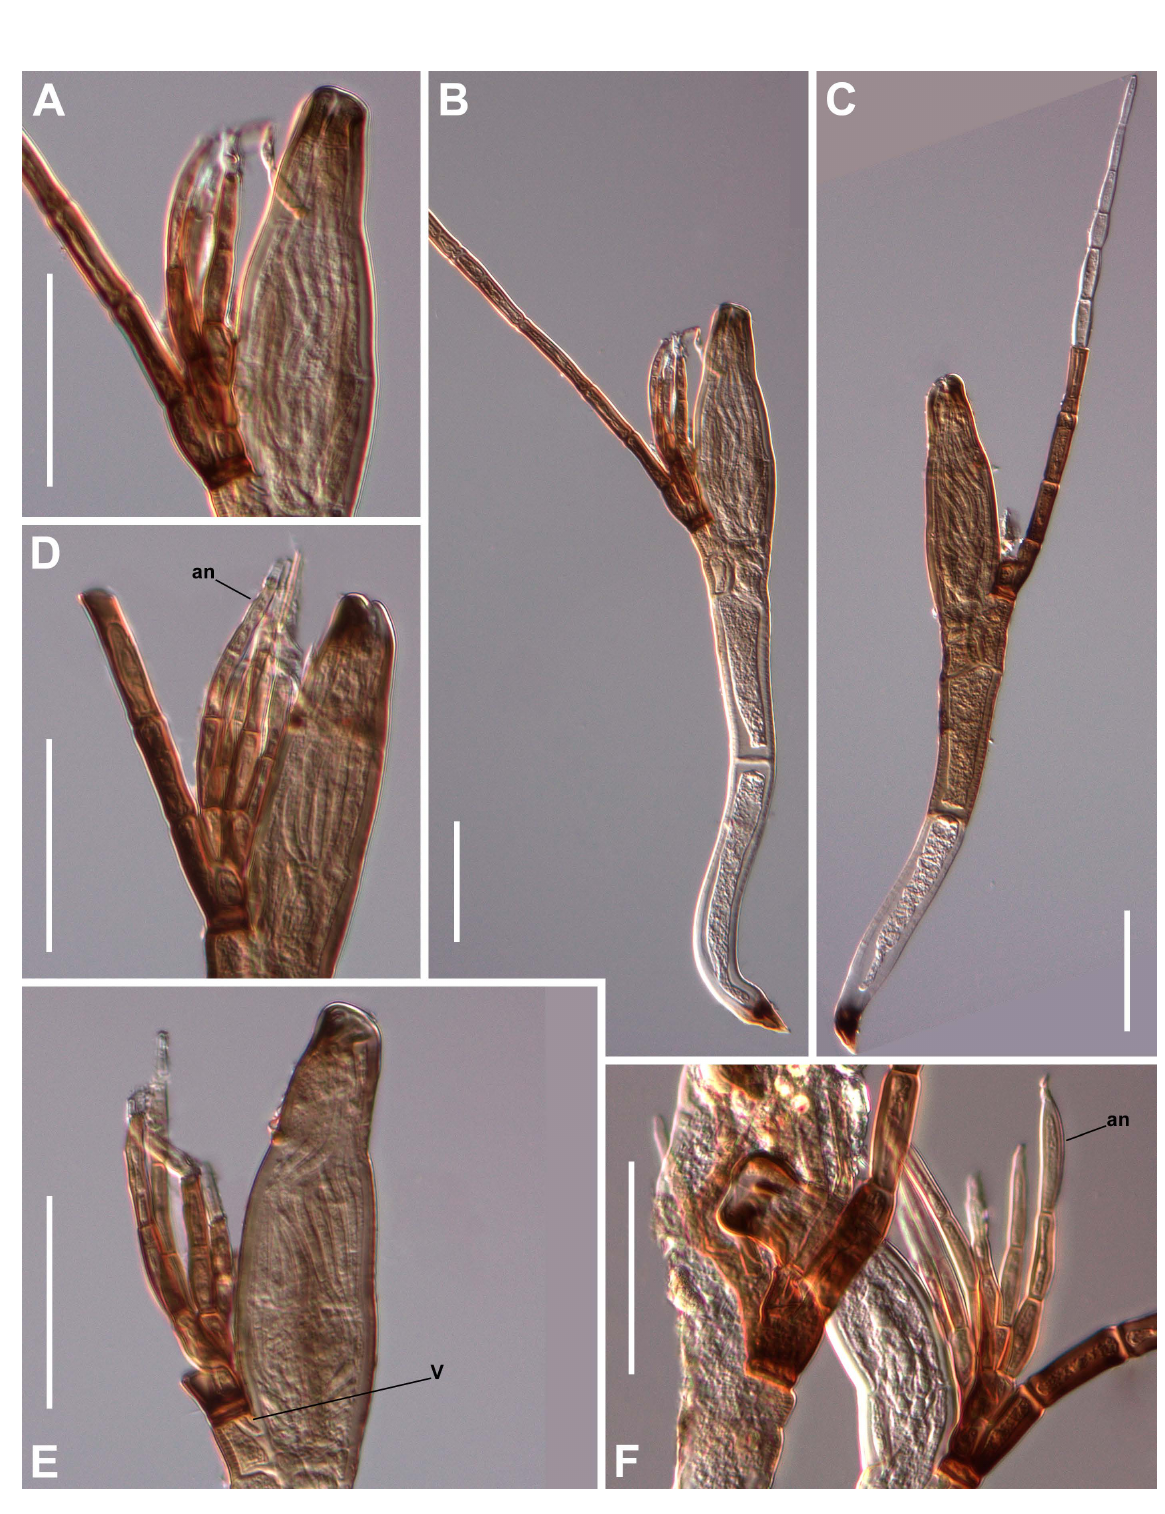
Fig. 42. Laboulbenia pygidicola Santam. sp. nov. B – C . Mature thalli. A , D – F . Inner appendage and surrounding areas in detail with labelled antheridia (an) and cell V. Scale bars: 50 µm. Photographs from slides ZMUC C-F-123384 (A–E) (holotype), ZMUC C-F-123025